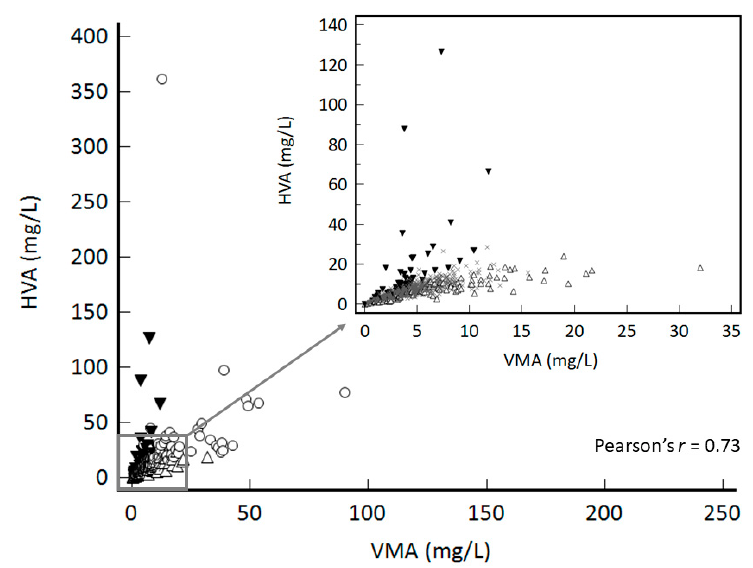
Figure 1. Relationship between 1209 VMA and HVA concentrations in 357 patients. Table 2. HVA and VMA measurements in combination for detection and monitoring of